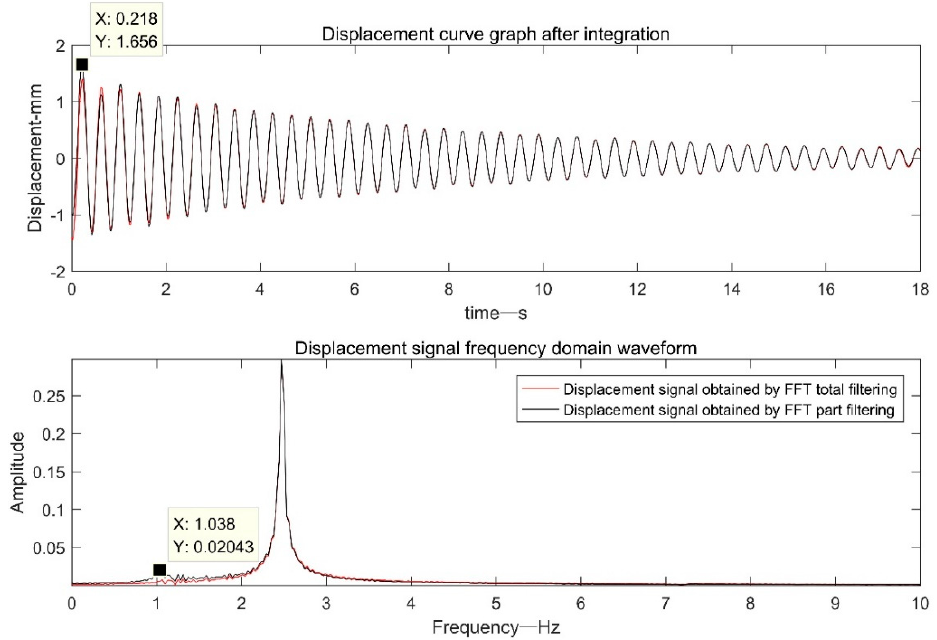
Figure 19. Figure 18a and Figure 18c displacement signal comparison chart.